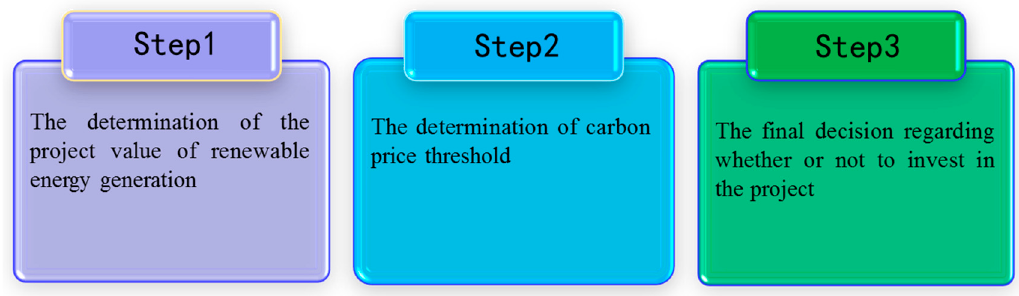
Figure 1. The steps of model for investment decisions for renewable energy projects.